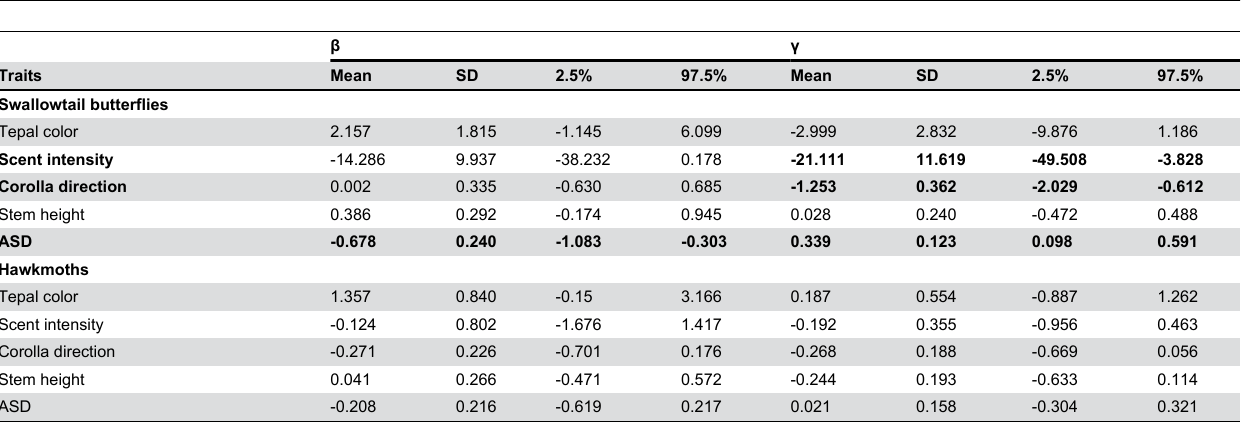
Table 5. Means and 95% confidence intervals of the posterior distribution of linear (β) and quadratic (γ) parameters in analyses of combined pollination success calculated with the observed Ave. X/Ave.